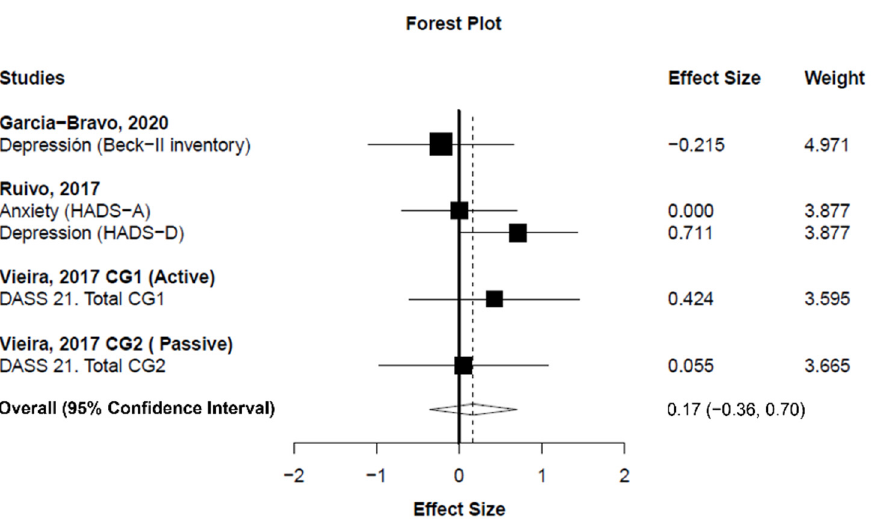
Figure 5. Forest plot showing the standardized mean difference between exergaming and conven- tional cardiac rehabilitation for mental health. Standardized mean difference greater than zero favors exergaming. CG: control group; HADS: Hospital Anxiety and Depression Scale.